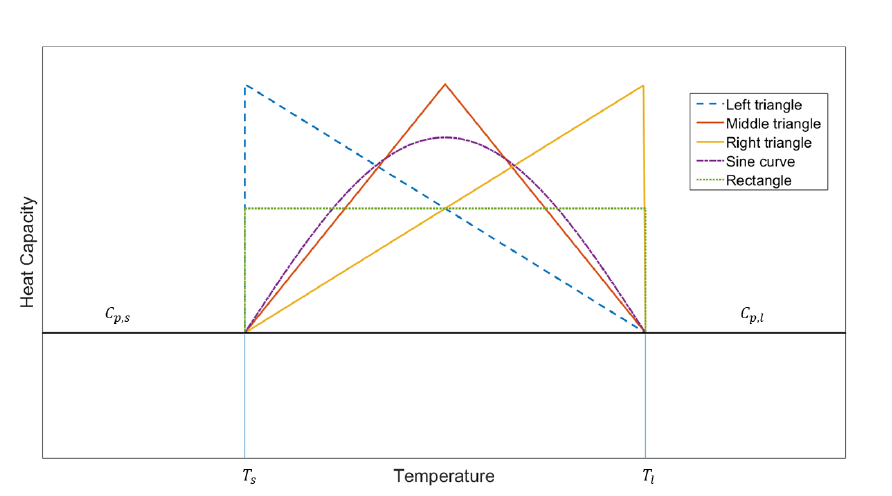
Figure 1. Different ways to model heat capacity during phase